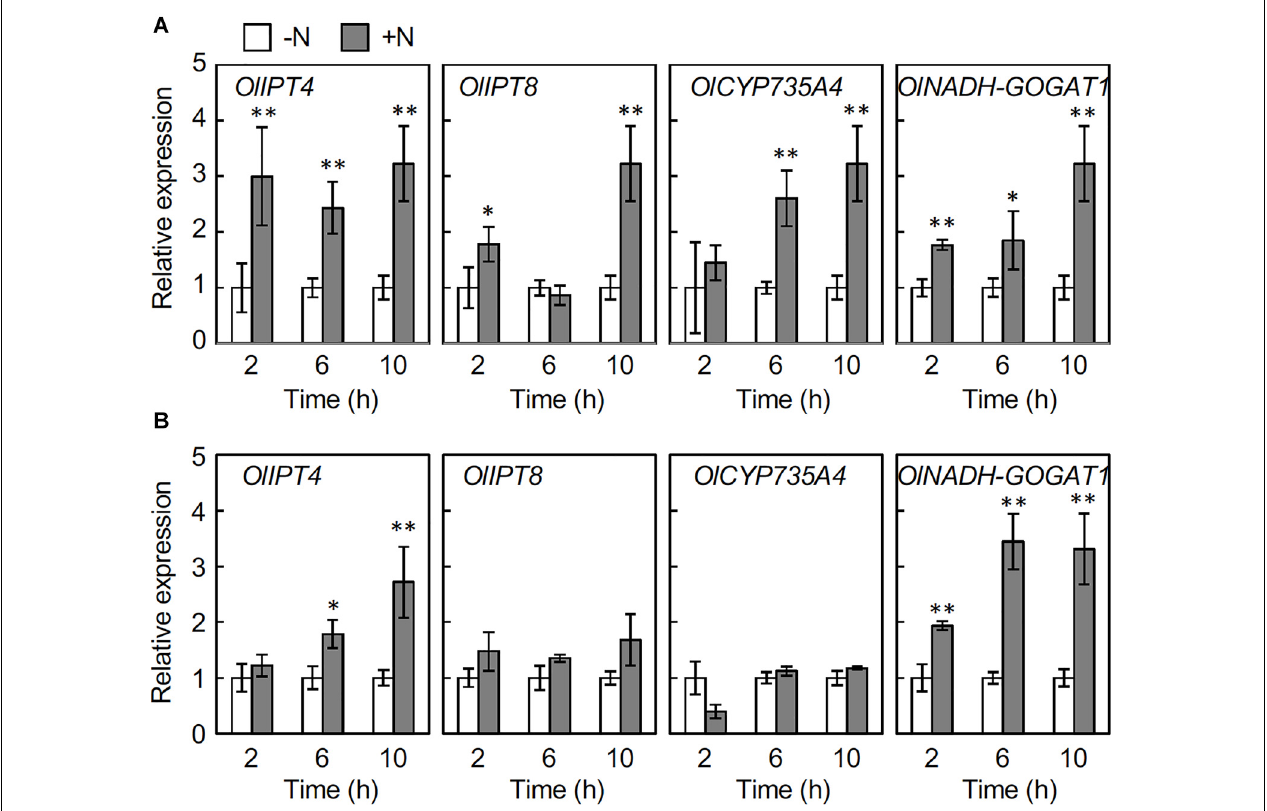
FIGURE 3 | Changes in the expression of cytokinin biosynthesis genes in rhizomes responding to nitrogen application. Young ramets having rhizomes at a similar growth stage were hydroponically grown in a low-N (200 µ M NH 4 NO 3 ) medium for 2 weeks. The ramets were subsequently transferred to culture media containing no nitrogen (-N) or 2 mM NH 4 NO 3 (+N). After incubation for the indicated times, rhizome roots and nodes with axillary buds were separately harvested. Total RNA prepared from the samples was subjected to RT-qPCR. Expression of the cytokinin biosynthesis genes in nodes including axillary buds (A) and roots (B) . Transcript abundance was normalized with OlUBQ1 and expressed as relative values with respect to the value in the -N treatment. Values are means ± SE ( n = 3). * P < 0.05; ** P < 0.01 (Student’s t test) compared to the -N